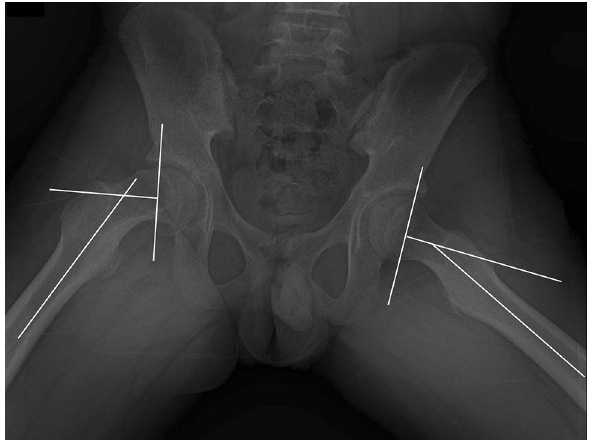
Figure 3. Measurement of the Southwick angle on a frog-leg lateral radiograph.